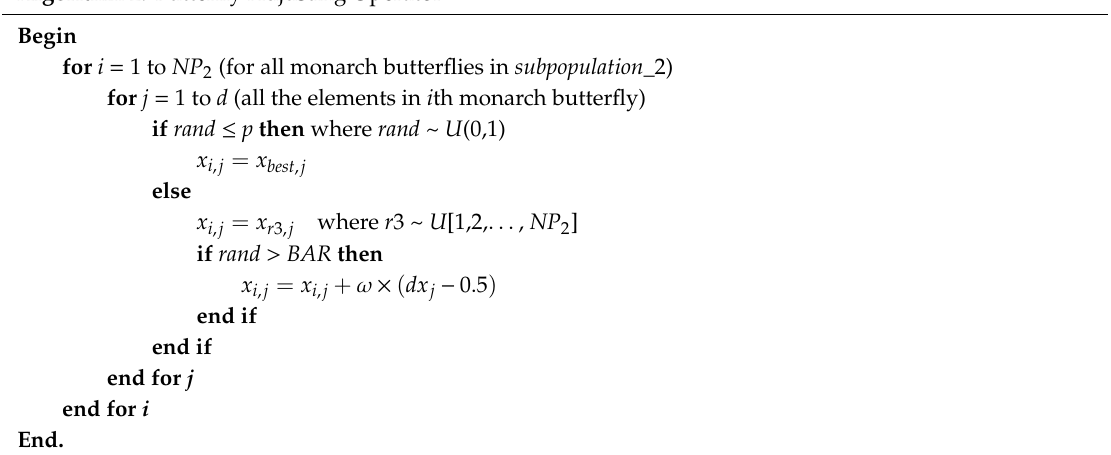
Algorithm 2. Butterfly Adjusting